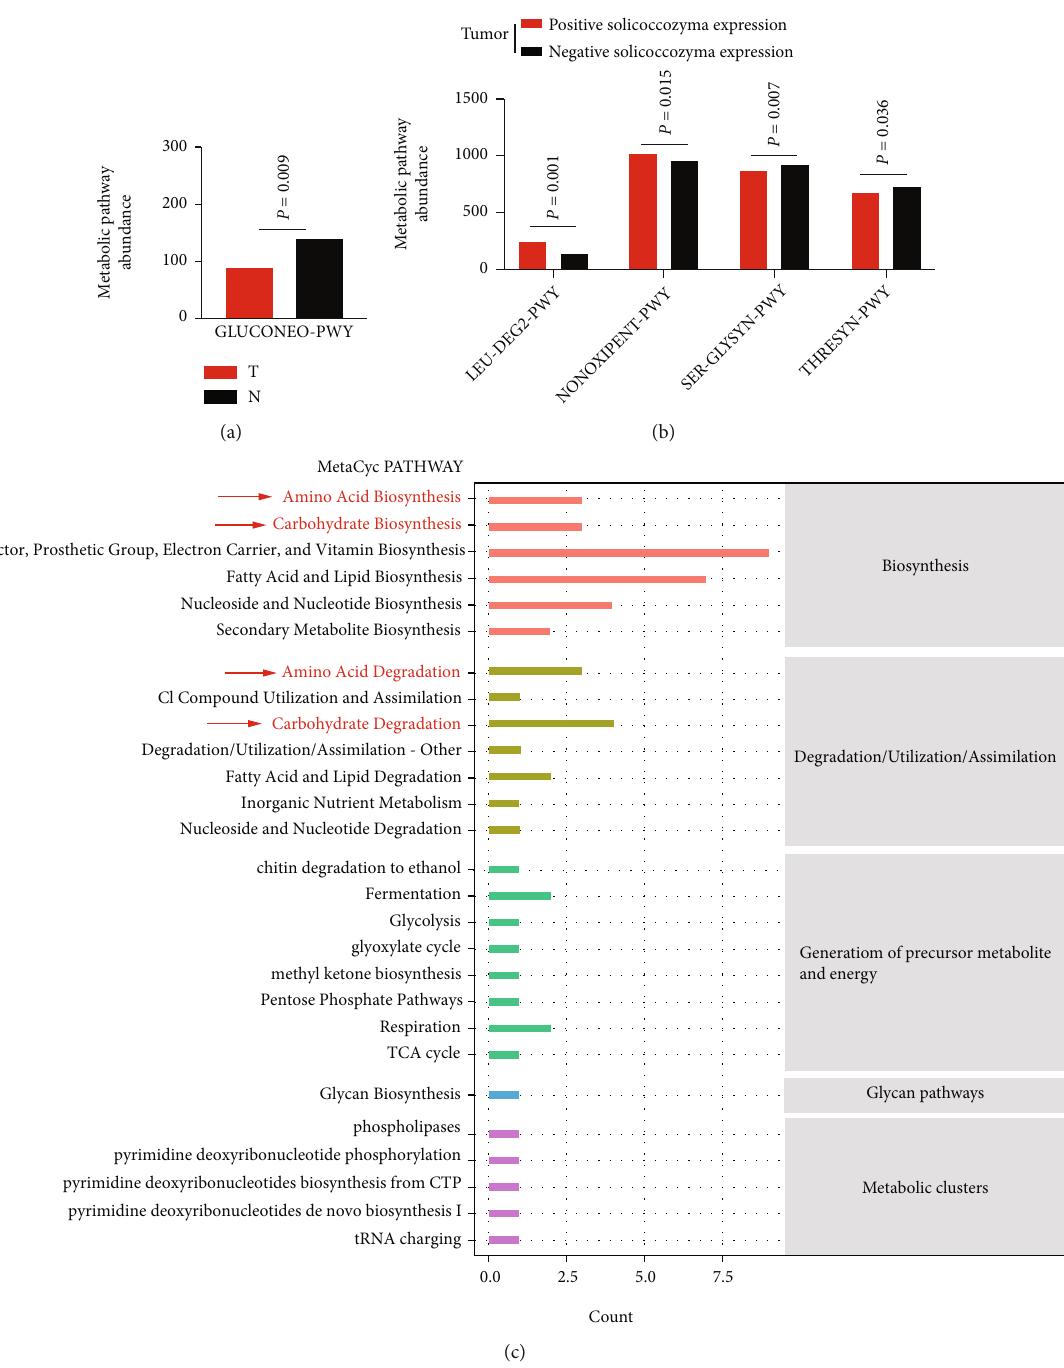
Figure 4: Functional prediction of the gastric mucosal fungal microbiota. (a) Metabolic pathways were enriched between the tumor and normal group; (b) the metabolic pathways were enriched in GC patients with Solicoccozyma- positive expression in tumors; (c) based on the OTU occurrence of the fungal microbiota and MetaCyc database, the metabolic processes were enriched and shown (red markers indicated amino acid- and carbohydrate-related metabolic